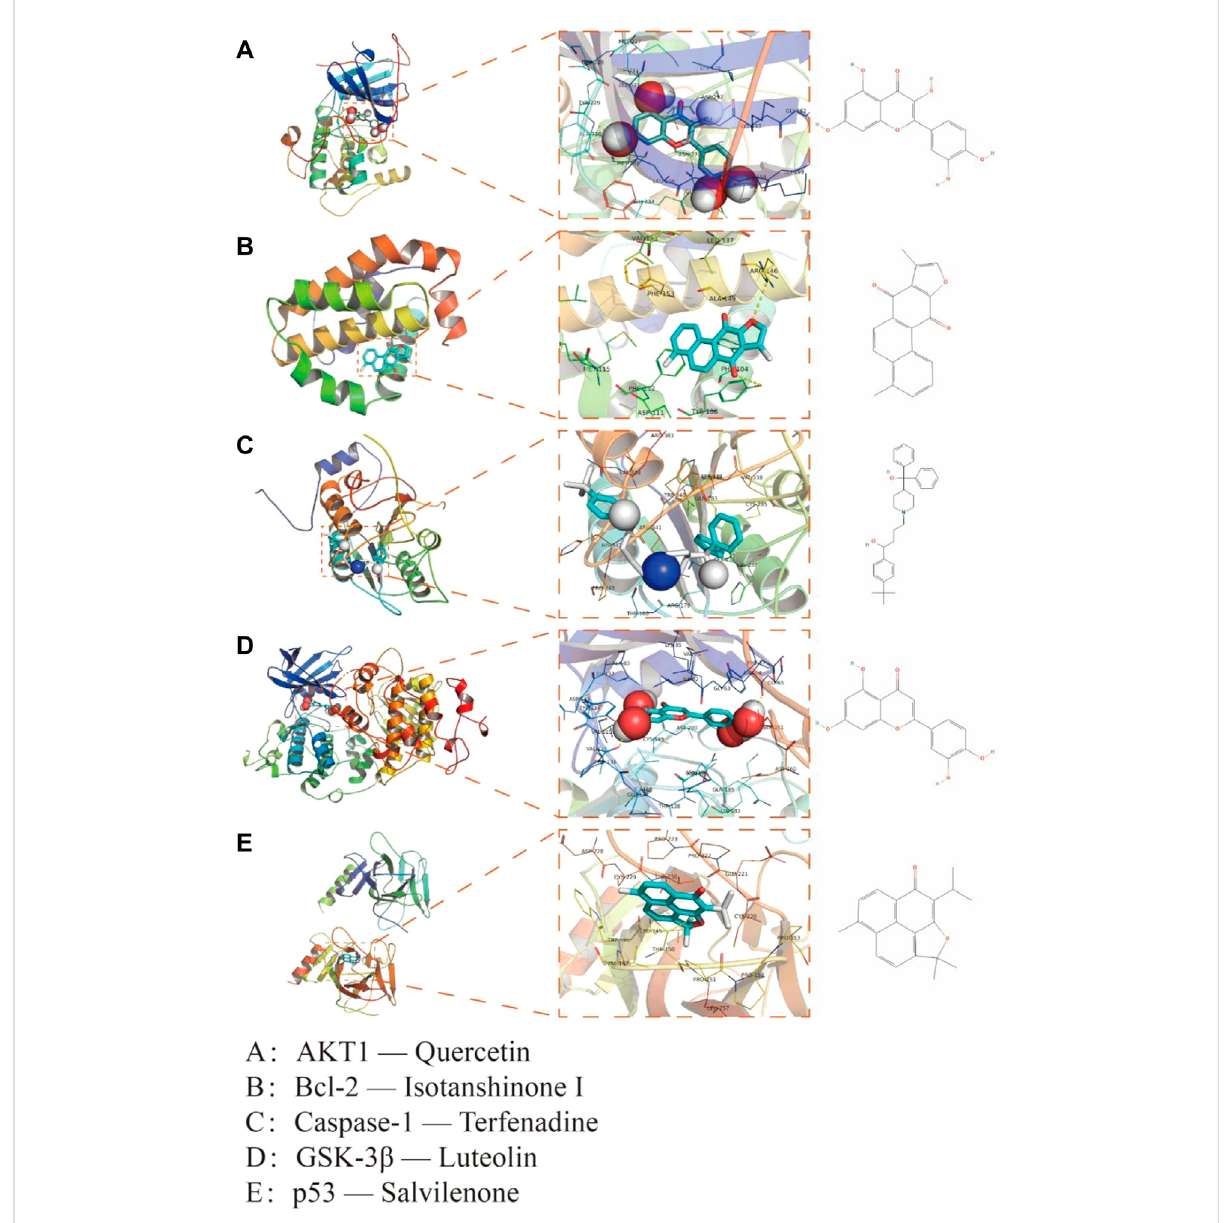
FIGURE 4 InteractionmodebetweenQSYQactive molecule andcore targeted proteinsobtained bymolecular dockingtechnique. (A) :AKT1 — Quercetin; (B): Bcl-2 — Isotanshinone Ⅰ ; (C): Caspase-1 — Terfenadine; (D): GSK-3 β — Luteolin; (E): p53 —